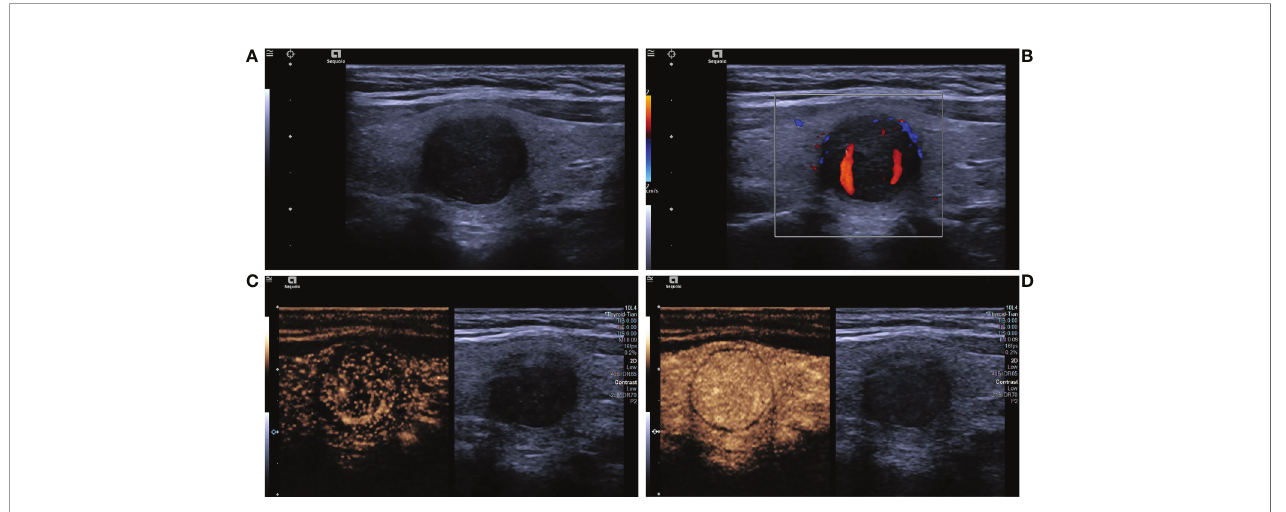
FIGURE 1 | Anodular goiter withadenomatoushyperplasiaina46-year-oldwoman. (A) Greyscaleultrasoundshowedthat therewasasolidveryhypoechoic noduleinthe rightlobeofthethyroid, withregular margin, wider-than-tallshape, andpunctateechogenicfoci.ThenodulewasACR TI-RADScategory5. (B) ColorDoppler showed intranodular andperipheralvascularity. (C) Contrast-enhancedultrasoundrevealeddiffusedenhancementwithinthenoduleatthetimeofthe11thsecondaftertheinjectionof contrast agent. (D) Contrast-enhancedultrasoundrevealediso-enhancementatpeak(the16thsecondafter the injectionofcontrastagent), withregular